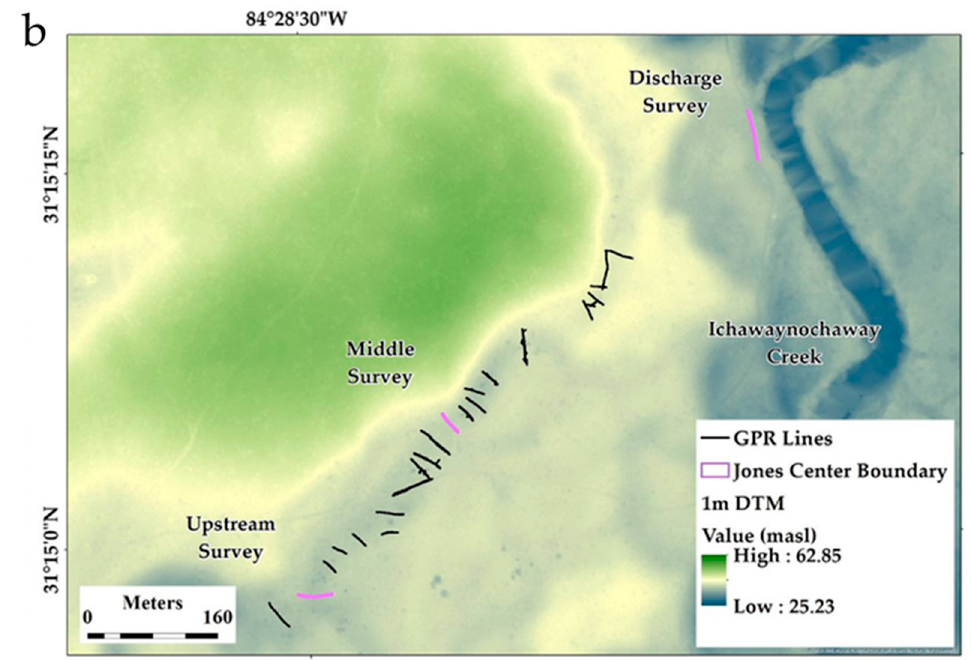
Figure 2. ( a ) Locations of several GIWs, of two long GPR transects, and of the high-density GPR grid are shown overlain on LiDAR DTM [33]; ( b ) locations of the sinkhole lineament within the draw, the GPR transects (black lines) between them, and Ichawaynochaway Creek overlain on LiDAR DTM [33]. Select GPR lines are colored purple.